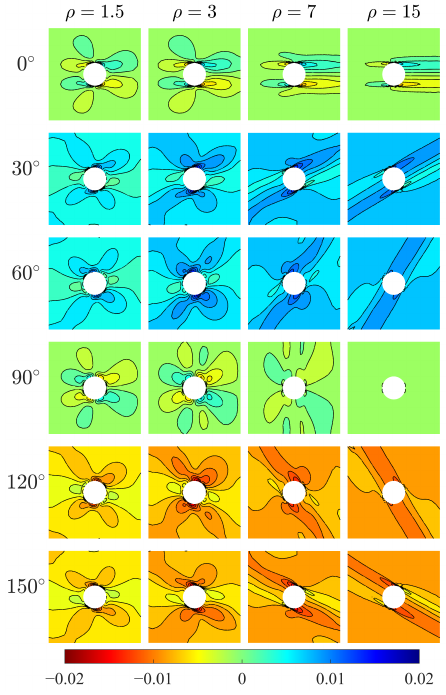
Figure 7. Relative rotation θ − ω of Cosserat